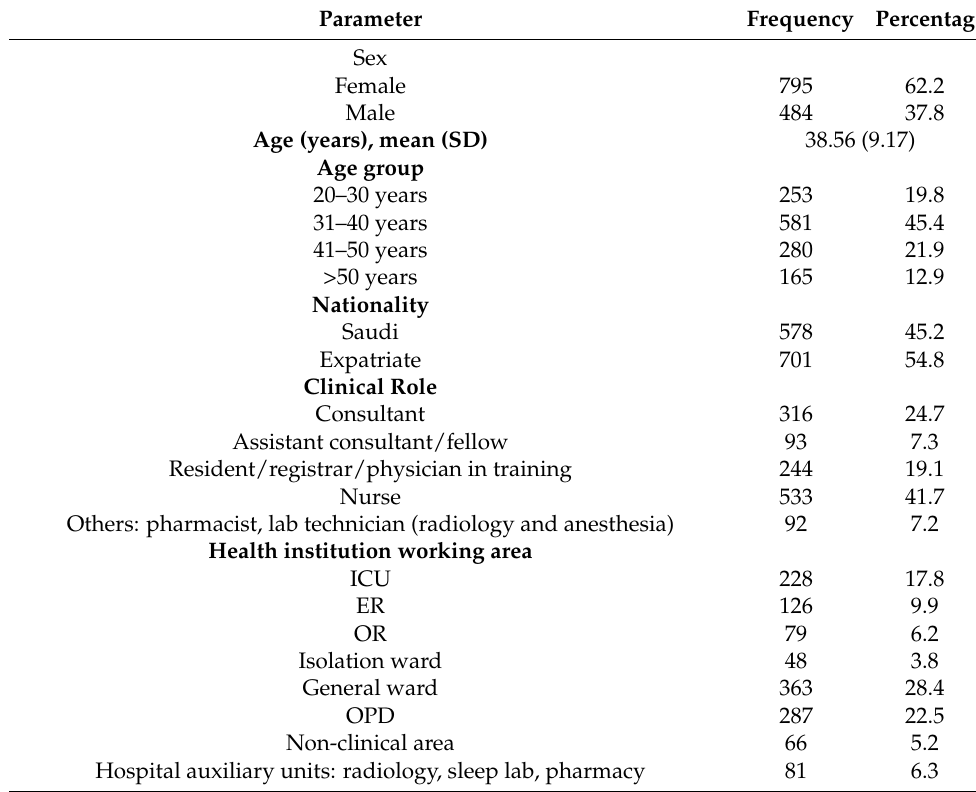
Table 1. Descriptive analysis of respondents’ sociodemographic and job characteristics. n =